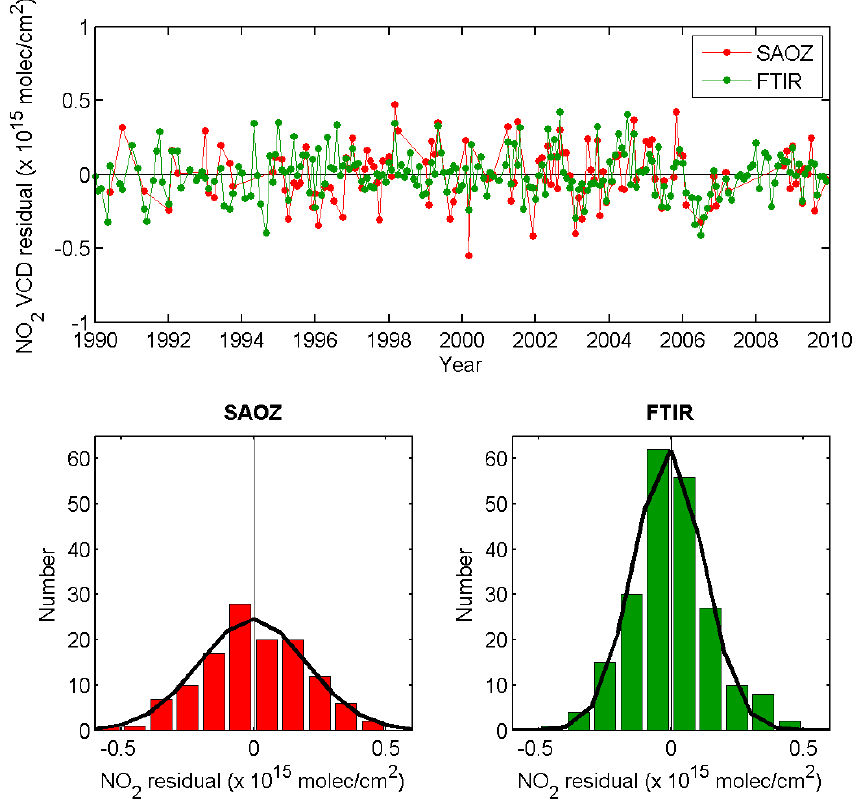
Fig. 6. SAOZ and FTIR fit residuals (upper plot) and their distributions (lower plots). Black lines correspond to Gaussian functions fitted on residuals distribution. Table 1. Trend values in %decade − 1 derived from FTIR, SAOZ, and satellite NO 2 column data sets for the 1990–2009 and 1996– 2009 periods. t B values appear between